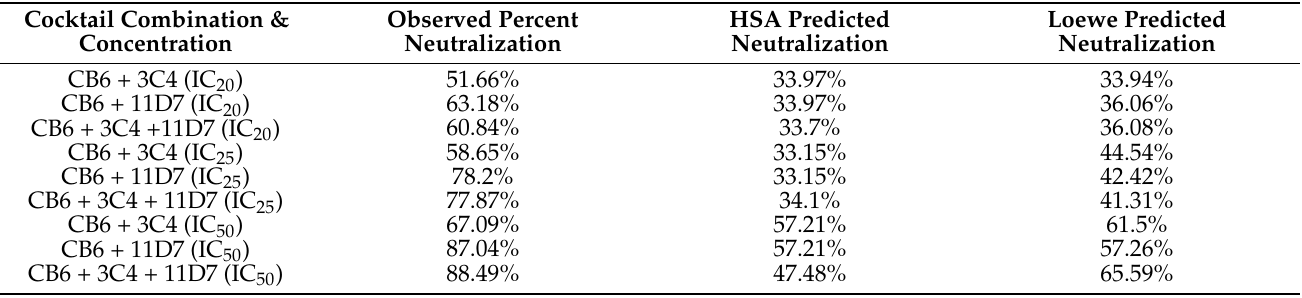
Figure 6. Competitive Binding to SARS-CoV-2 RBD. Serial dilutions of each mAb were coated on a 96-well plate prior to incubation with SARS-CoV-2 RBD. Then, either CR3022 ( A ) or CB6 ( B ) conjugated to horseradish peroxidase (HRP) were used to detect either overlapping or complemen- tary binding with each individual mAb. Error bars represent the SD of two independent experiments. Table 2. Neutralization synergy analysis of plant-made CB6 with other anti-SARS-CoV-2 RBD neutralizing mAbs. FFA experiments were performed for each individual nAb as well as nAb combinations with each nAb at concentrations that correspond to its IC 20 , IC 25 , and IC 50 . Neutral- ization data from two independent experiments were analyzed using the HSA and Loewe models (SynergyFinder.org). Predicted neutralization values represent the percent neutralization of nAb combinations, where there is no synergistic interaction between different nAbs in the cocktail at the indicated IC value. These predicated neutralization values were calculated from the actual neutralization data of each individual nAb in the cocktail, assuming there is no interaction between the nAbs in the